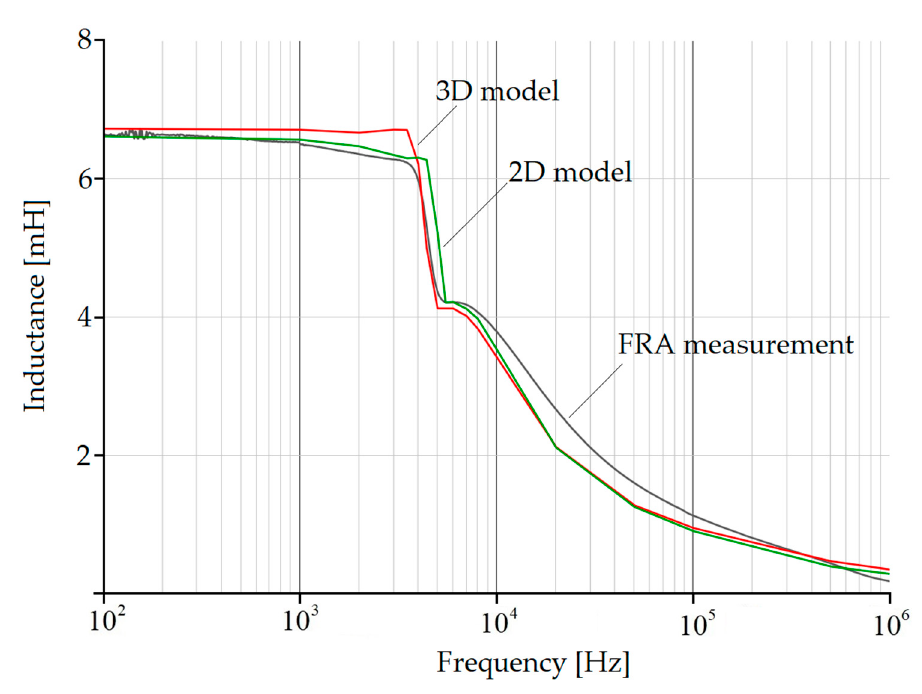
Figure 9. The inductance of the tested coil as a function of frequency. 2D and 3D finite elements method (FEM) models compared with the inductance obtained from frequency response analysis (FRA) measurements.